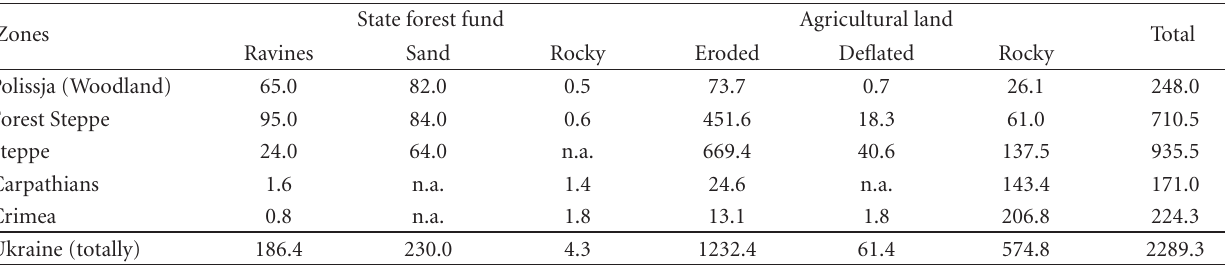
Table 1: Potential for a ff orestation by land use across zones, kha.